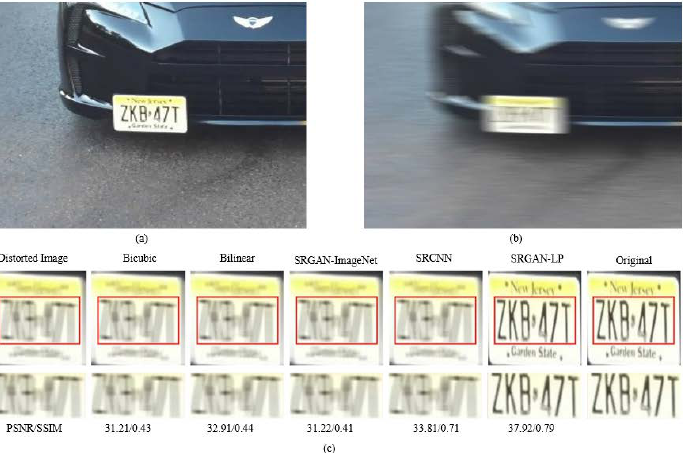
Figure 6. ( a ) Ground truth image (original image), ( b ) Motion blur applied on whole image (distorted image), ( c ) Visual quality of the reconstructed images along with the corresponding PSNR/SSIM scores.